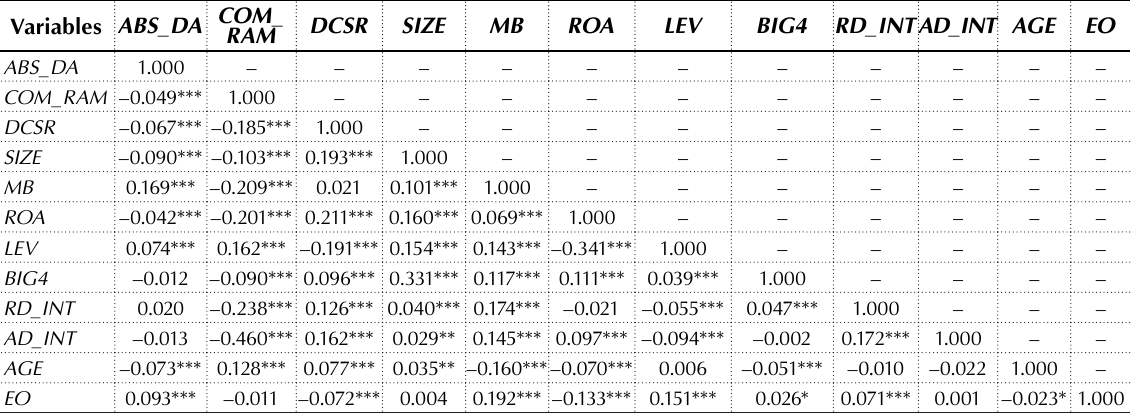
Table 3. Correlation